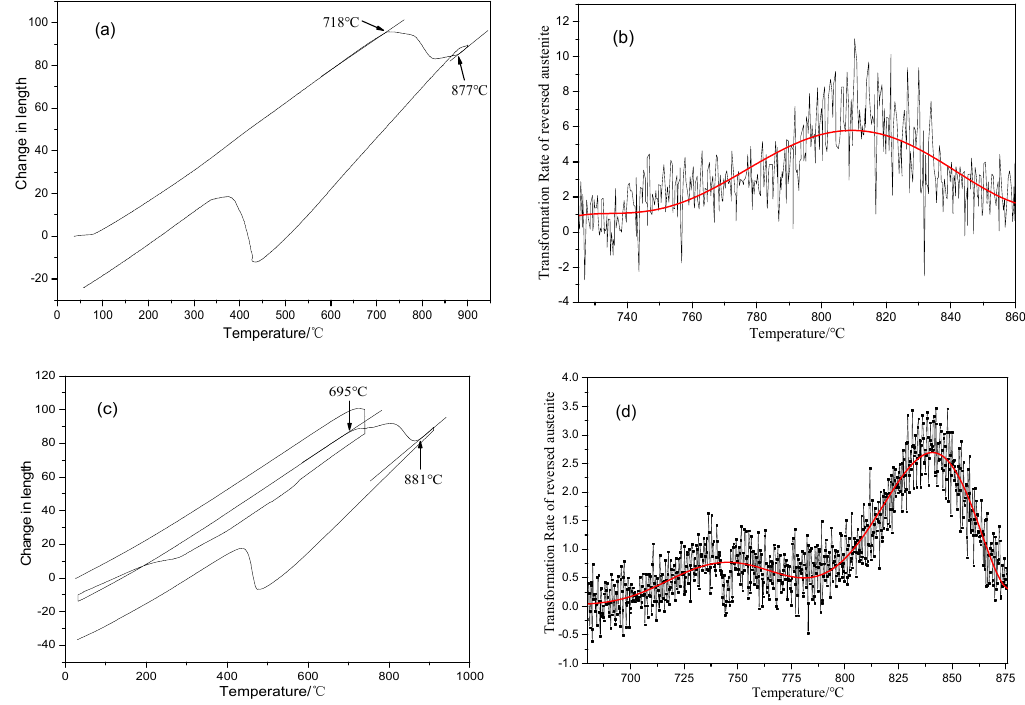
Figure 5. Gleeble simulated curves of one-step ( a ) and two-step ( c ) heat treatment; the austenite transformation rate curves of one-step ( b ) and two-step ( d ) heat treatment.